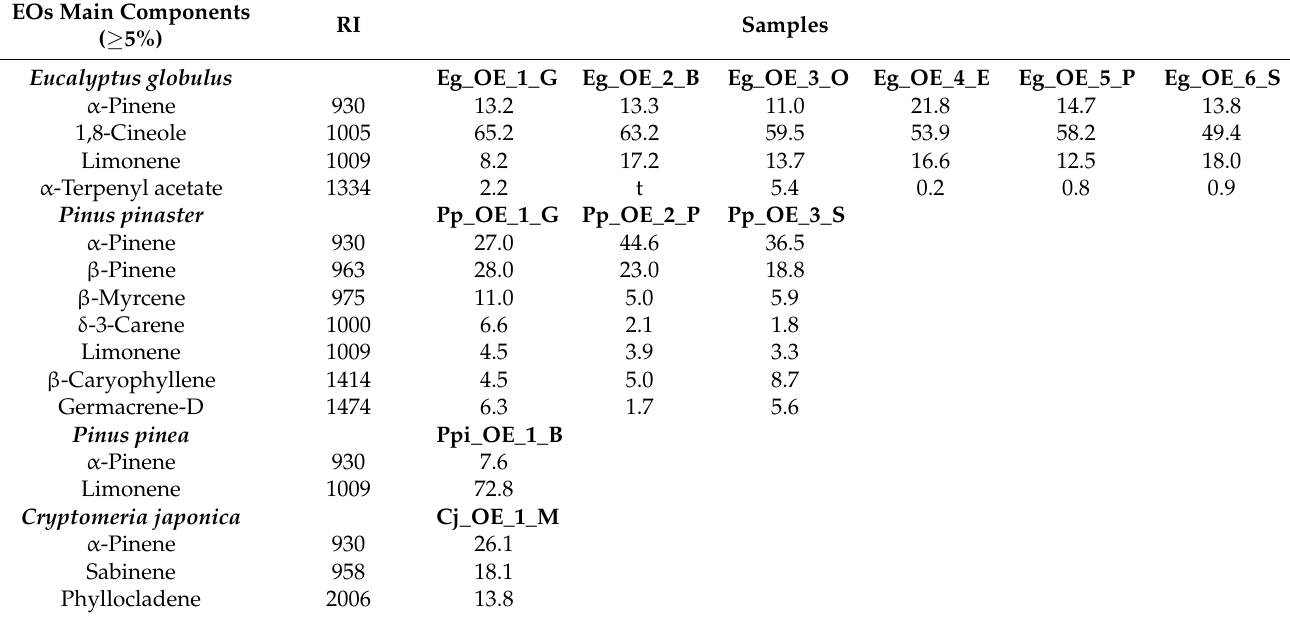
Table 1. Percentage composition of the main components ( ≥ 5%) of Eucalyptus globulus , Pinus pinaster, Pinus pinea and Cryptomeria japonica essential oils (EOs). For sample codes vide Materials and Methods